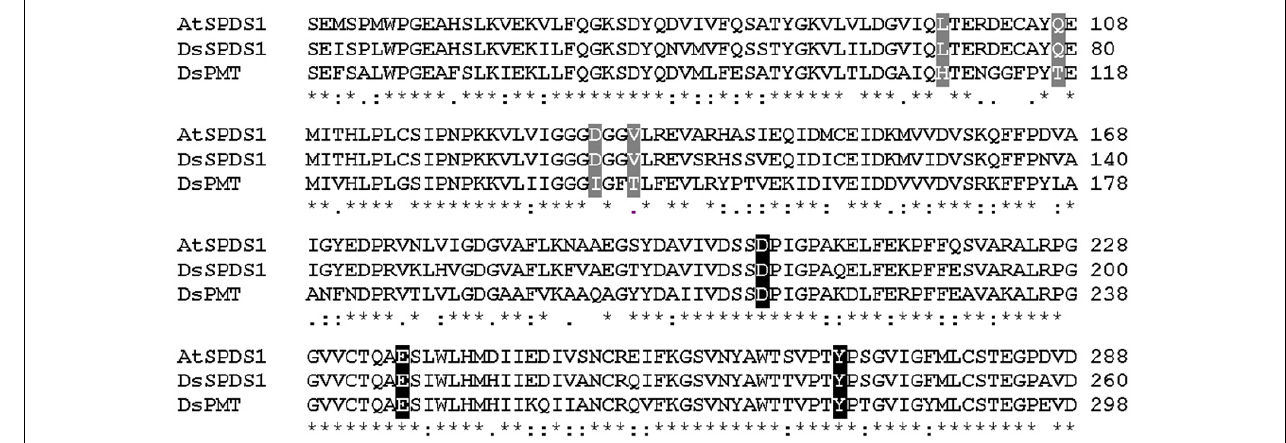
binding site: gray, changes in putrescine binding site: black; Gonnet-Matrix; ∗ single, fully conserved residue; : conservation between groups of strongly similar properties; . conservation between groups of weakly similar properties.